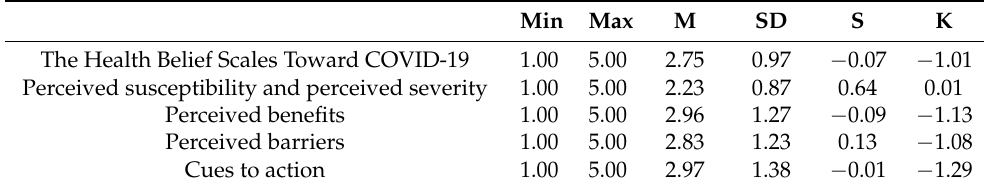
Table 3. Descriptive statistics of the Health Belief Scales Toward